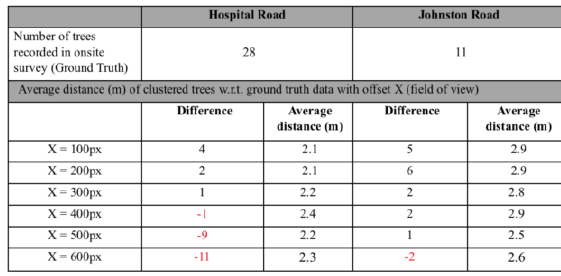
Table 1. Summary of results for number of clustered trees in different offset value X for the “field of view” filter.